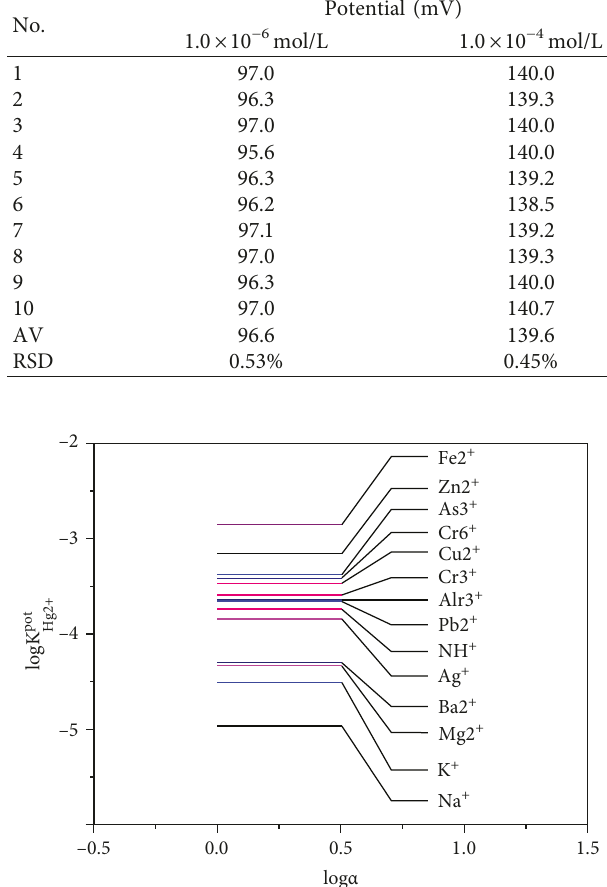
TFPB-TZT electrode.